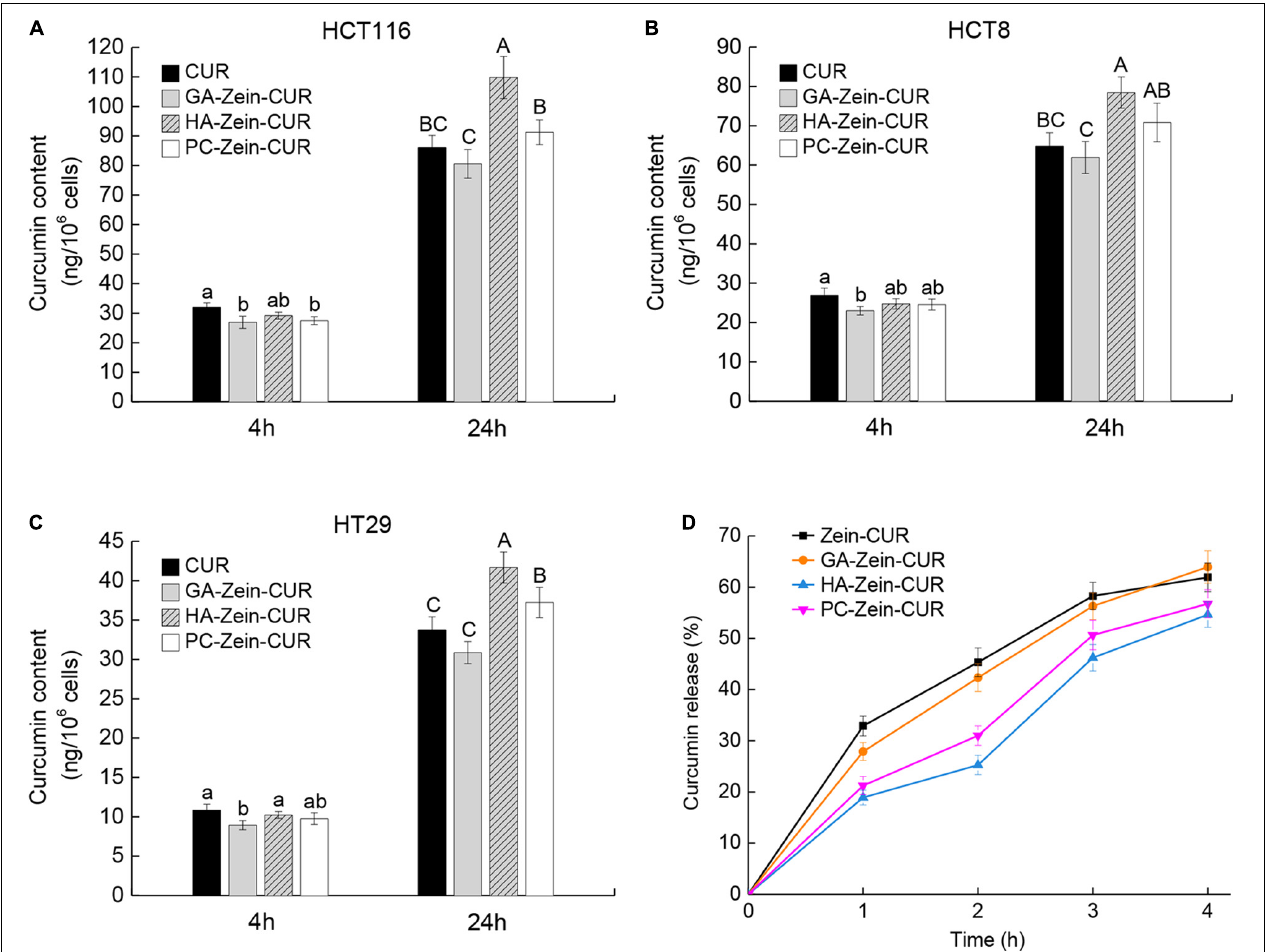
FIGURE 5 | Cellular uptake and simulated gastrointestinal digestion (SDIG) of PS-Zein-CUR. (A–C) CUR contents in CRC cells incubated, respectively with CUR and PS-Zein-CUR for 4 and 24 h. Values are mean ± SD, n = 3. Bars marked with different letters indicate significant difference at P < 0.05. (D) CUR release from Zein-CUR and PS-Zein-CUR during SDIG. Values are mean ± SD, n = 3.